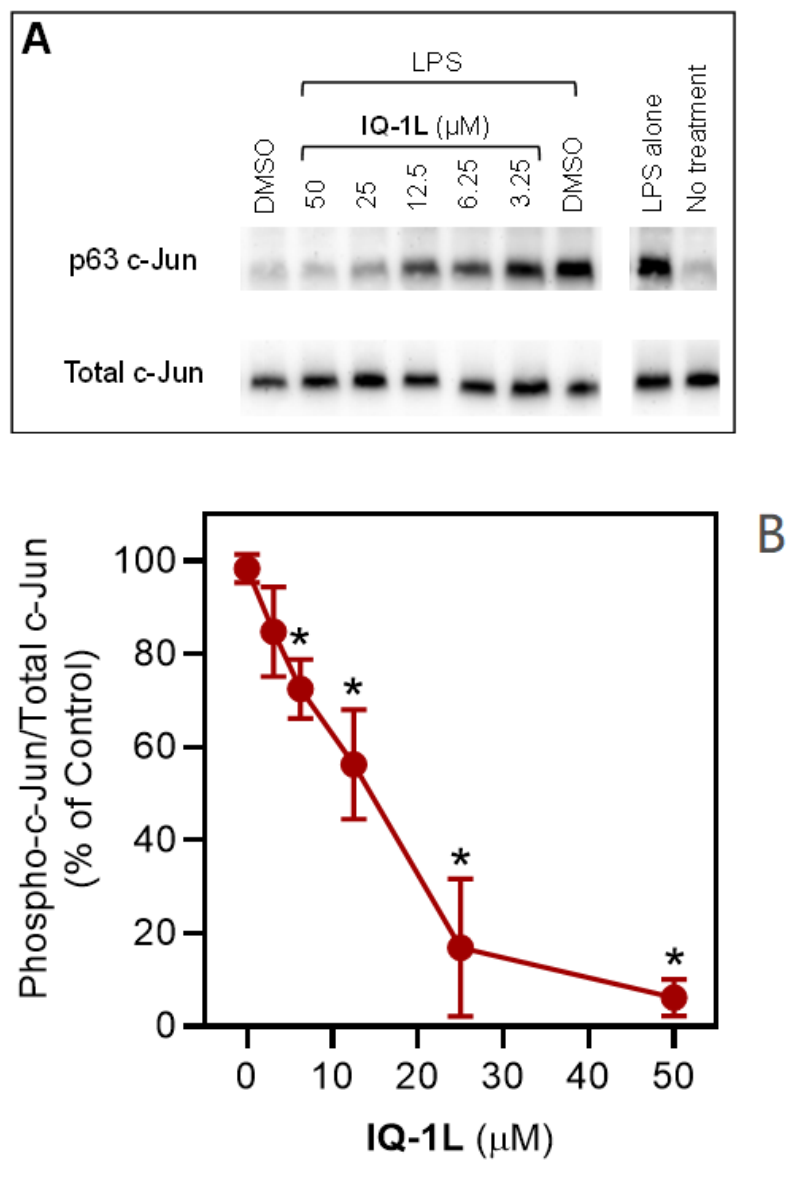
Figure 5. Effect of IQ-1L on LPS-induced c-Jun (Ser63) phosphorylation. Human MonoMac-6 monocytic cells were pretreated with indicated concentrations of IQ-1L or 0.5% DMSO for 30 min, followed by treatment with LPS (250 ng/mL) or control buffer for another 30 min. Controls with cells alone (no DMSO) or cells treated with LPS alone were also included. The cells were lysed, and the lysates were analyzed by Western blotting on 10% SDS-PAGE gels. After blotting for phospho-c-Jun, the same blots were stripped and reblotted for total JNK as a loading control for the lysates. Representative blots from three independent experiments are shown ( A ). The blots were analyzed by densitometry, as described under Materials and Methods , and the ratio of phospho-c-Jun/total c-Jun is shown in ( B ). Values are expressed as mean ± S.D. of three independent experiments. * p < 0.05 compared with DMSO + LPS-treated control cells.